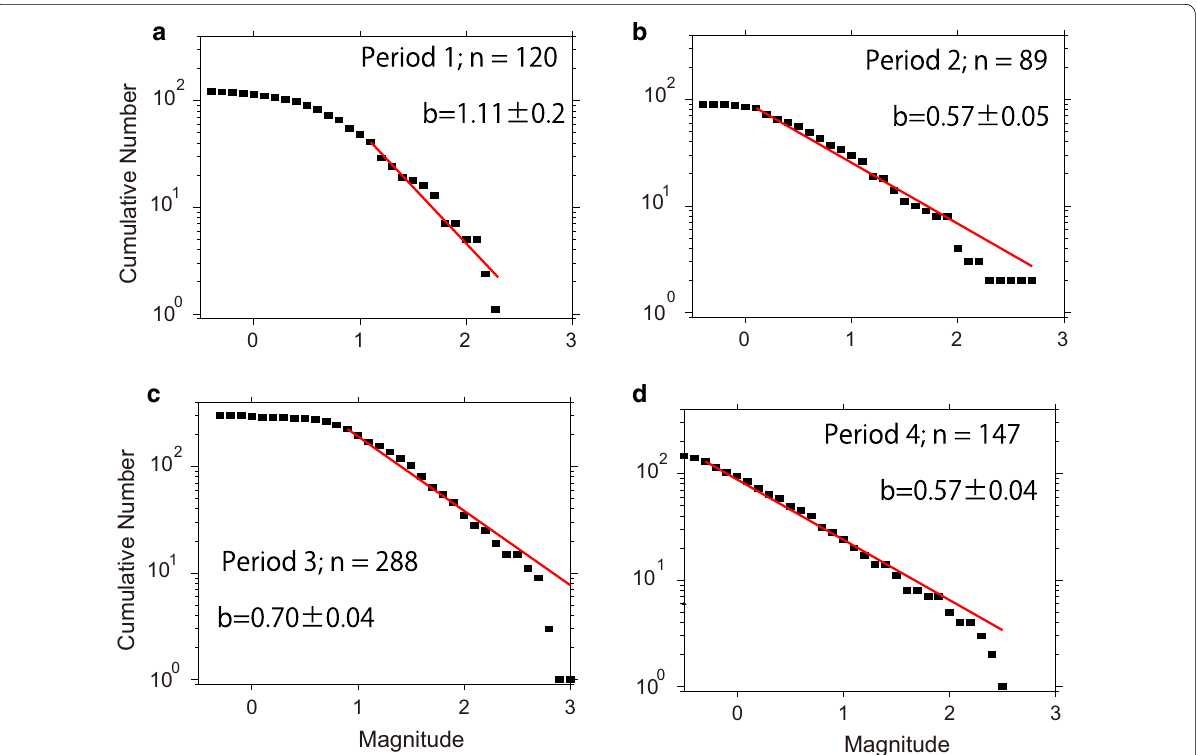
Fig. 4 b -values estimated in region B for each analysis window: before the 2011 eruption (period 1: January 1, 2007–January 18, 2011); during and immediately after the 2011 eruption (period 2: January 19, 2011–December 31, 2011); before the 2017 eruption (period 3: January 1, 2012– September 30, 2017); and immediately before and during the 2017 eruption (period 4: October 1, 2017–October 26, 2017). The analyzed region is located 7.0–8.0 km northwest of the summit (region B). n and b in the figures indicate the number of events and representative b -values of each analysis period,